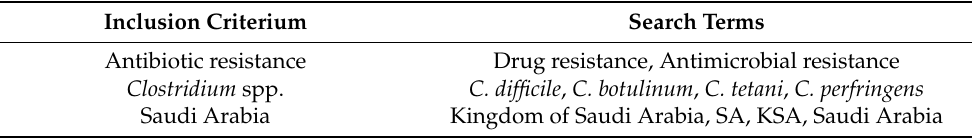
Table 1. Search terms used in the electronic database search. Inclusion Criterium Search Terms Antibiotic resistance Drug resistance, Antimicrobial resistance Clostridium